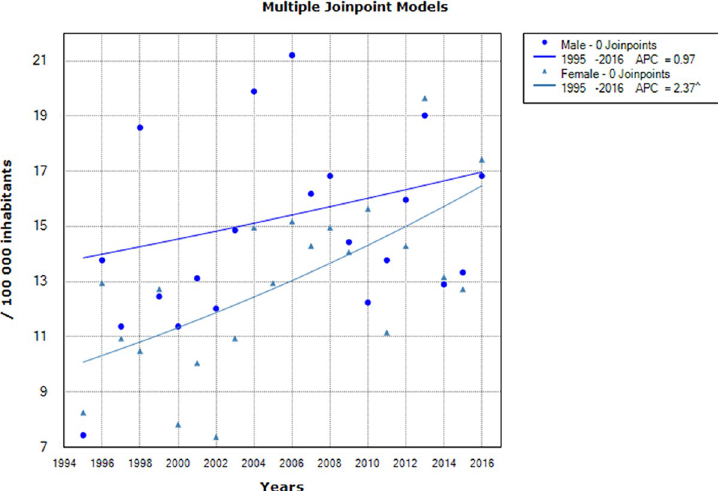
Fig 2. Chronological trends analysis of tuberculosis incidence rates by gender between 1995 and